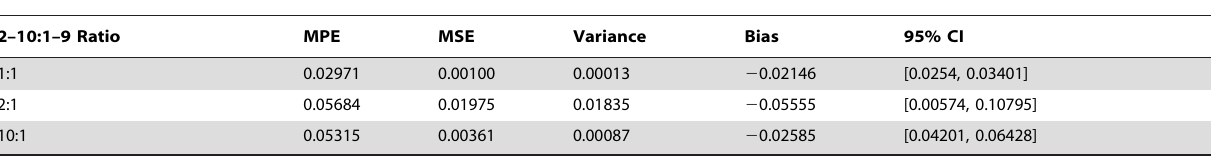
Table 3. Secondary peptide ratio